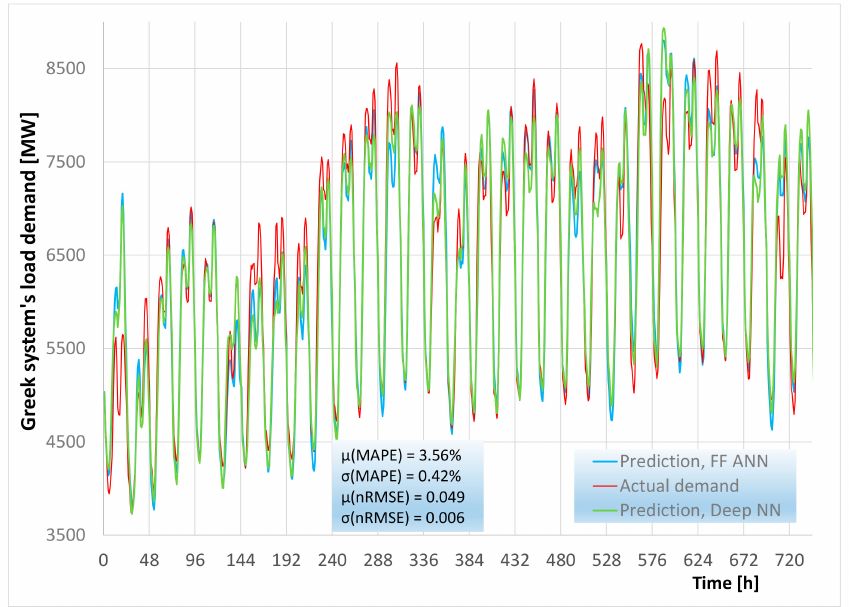
Figure 17. Prediction and validation of system’s demand for January 2022, FF-ANN after 81 epochs versus deep NN after 1000 epochs. Modeling error metrics are shown for deep FNN predictions for the whole year